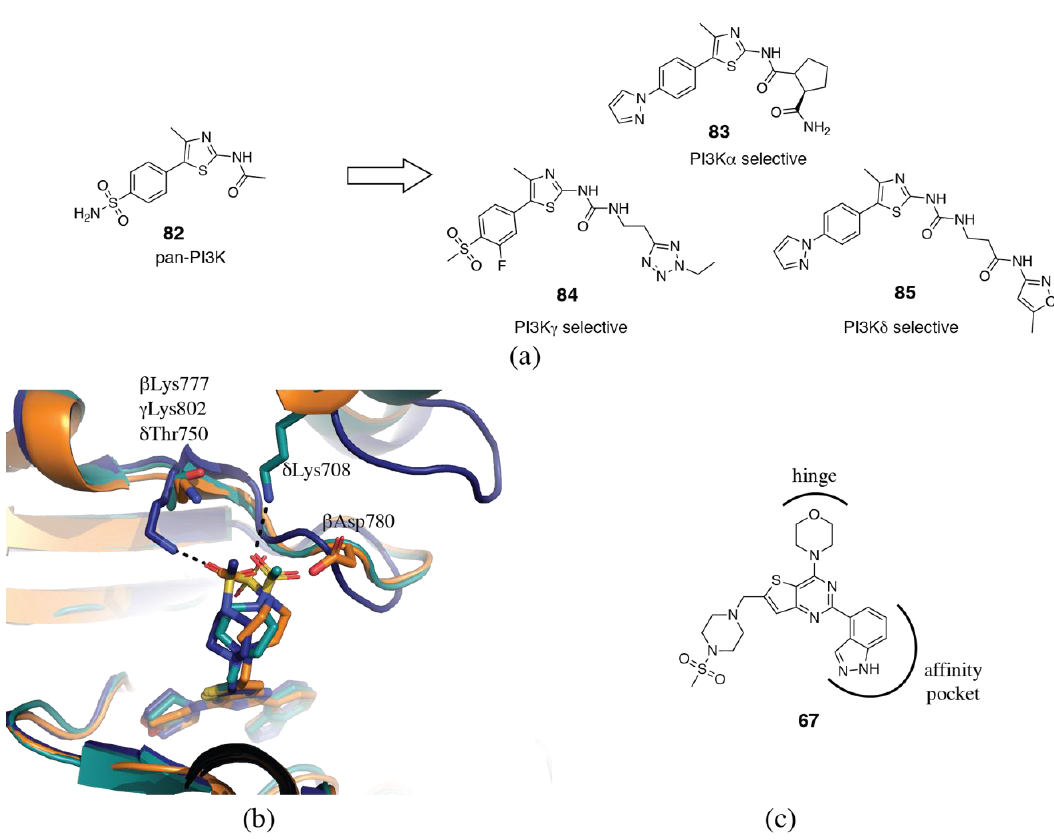
Figure 13. Rational and irrational selectivity. ( a ) The rational design of isoform selective inhibitors 83 - 85 from a pan-PI3K core ( 82 ). ( b ) GDC-0941 ( 67 ) bound to p110 β (orange, PDB ID 2Y3A), p110 γ (dark blue, PDB ID 3DBS) and p110 δ (teal, PDB ID 2WXP). The sulfonyl group shifts conformation depending on which non-conserved residues are present. Hydrogen bonds have been shown in black dashed lines. ( c ) The structure of GDC-0941 ( 67